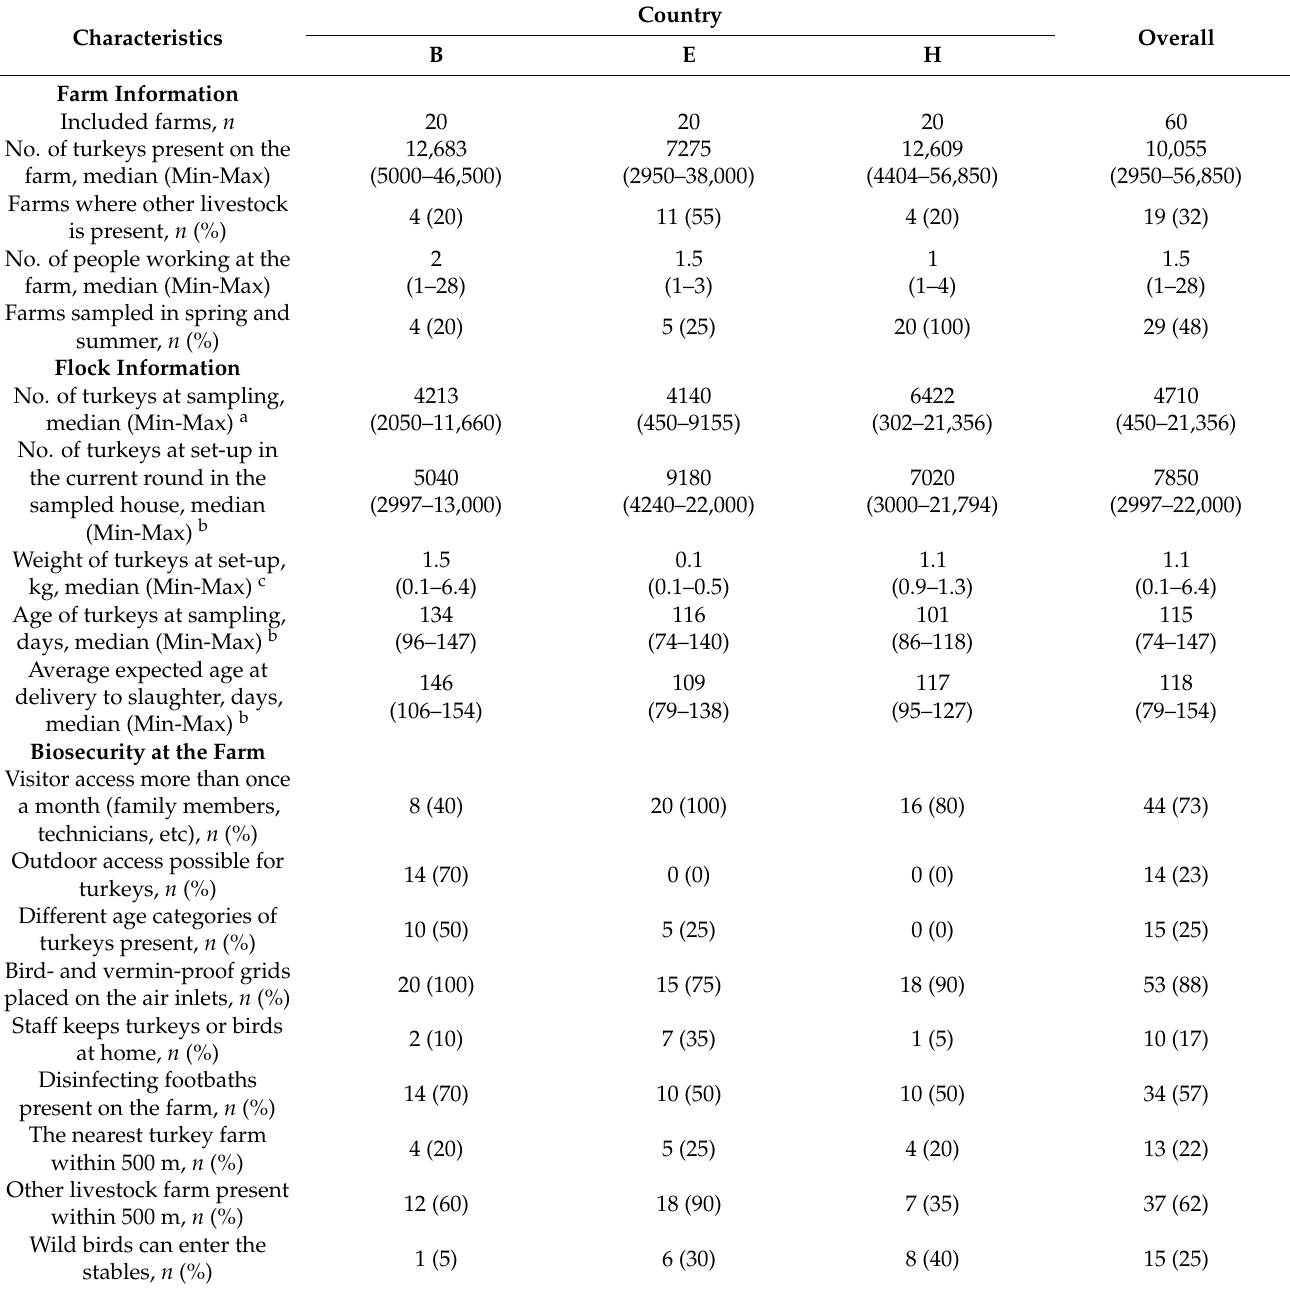
Table 1. Characteristics of the sampled turkey farms and flocks by country and overall